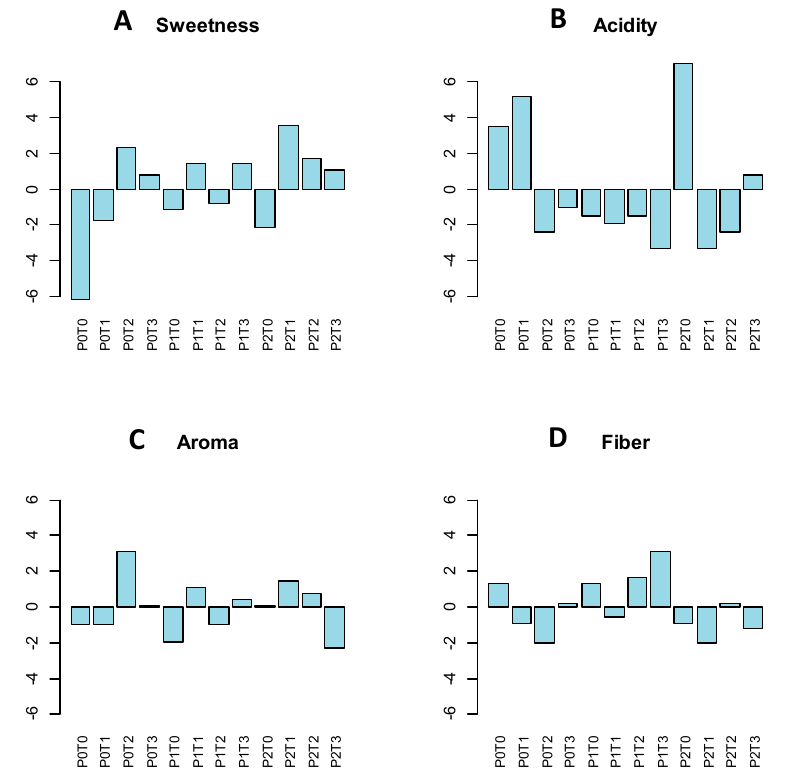
Figure 4. Sensory profile of fruit from organo-mineral fertilizers: ( A ) sweetness; ( B ) acidity; ( C ) Aroma; ( D ) Fiber. On the Y axis, V-computed from the V-test in comparison of the mean value of the sensorial parameter for a given treatment to the overall mean. A V-computed greater than 2 means the treatment had significantly ( p < 0.05) greater value for the given parameter. But t-computed lower than -2 implies that the treatment had significantly lower ( p < 0.05) value for the given parameter. P0T0: 0 t ha − 1 of poultry litter and N-P-K in Kg ha − 1 100-30-150, P0T1: 0 t ha − 1 of poultry litter and N-P-K in Kg ha − 1 200-60-300, P0T2: 0 t ha − 1 of poultry litter and N-P-K in Kg ha − 1 400-120-600, P0T3: 0 t ha − 1 of poultry litter and N-P-K in Kg ha − 1 600-180-900, P1T0: 5 t ha − 1 of poultry litter and N-P-K in Kg ha − 1 100-30-150, P1T1: 5 t ha − 1 of poultry litter and N-P-K in Kg ha − 1 200-60-300, P1T2: 5 t ha − 1 of poultry litter and N-P-K in Kg ha − 1 400-120-600, P1T3: 5 t ha − 1 of poultry litter and N-P-K in Kg ha − 1 600-180-900, P2T0: 10 t ha − 1 of poultry litter and N-P-K in Kg ha − 1 100-30-150, P2T1: 10 t ha − 1 of poultry litter and N-P-K in Kg ha − 1 200-60-300, P2T2: 10 t ha − 1 of poultry litter and N-P-K in Kg ha − 1 400-120-600, P2T3: 10 t ha − 1 of poultry litter and N-P-K in Kg ha − 1